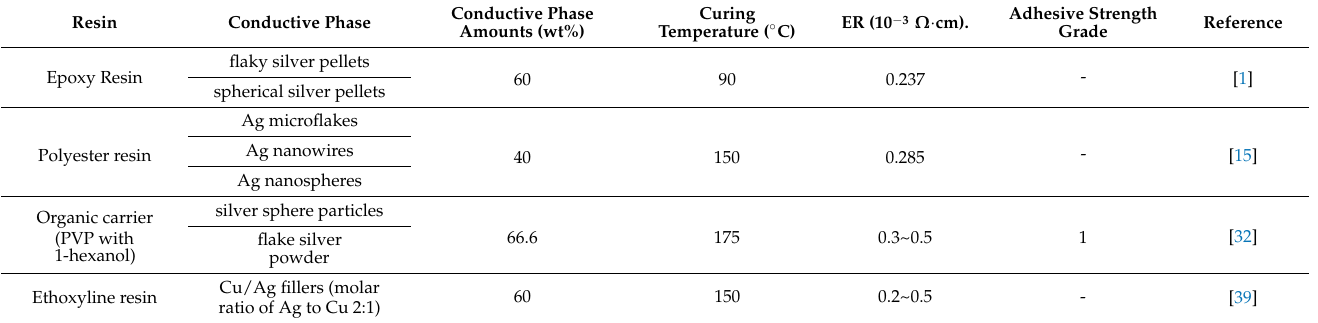
Figure 9. TG curves of ( a ) Ag NPs without other heat treatment, ( b ) Ag NWs without other heat treatment and ( c ) Ag MFs without other heat treatment. The insets show a magnified TG curve in the range of 110–200 °C for Ag NPs, in the range of 110–200 °C for Ag NWs, and in the range of 100– 200 °C for Ag MFs, respectively.